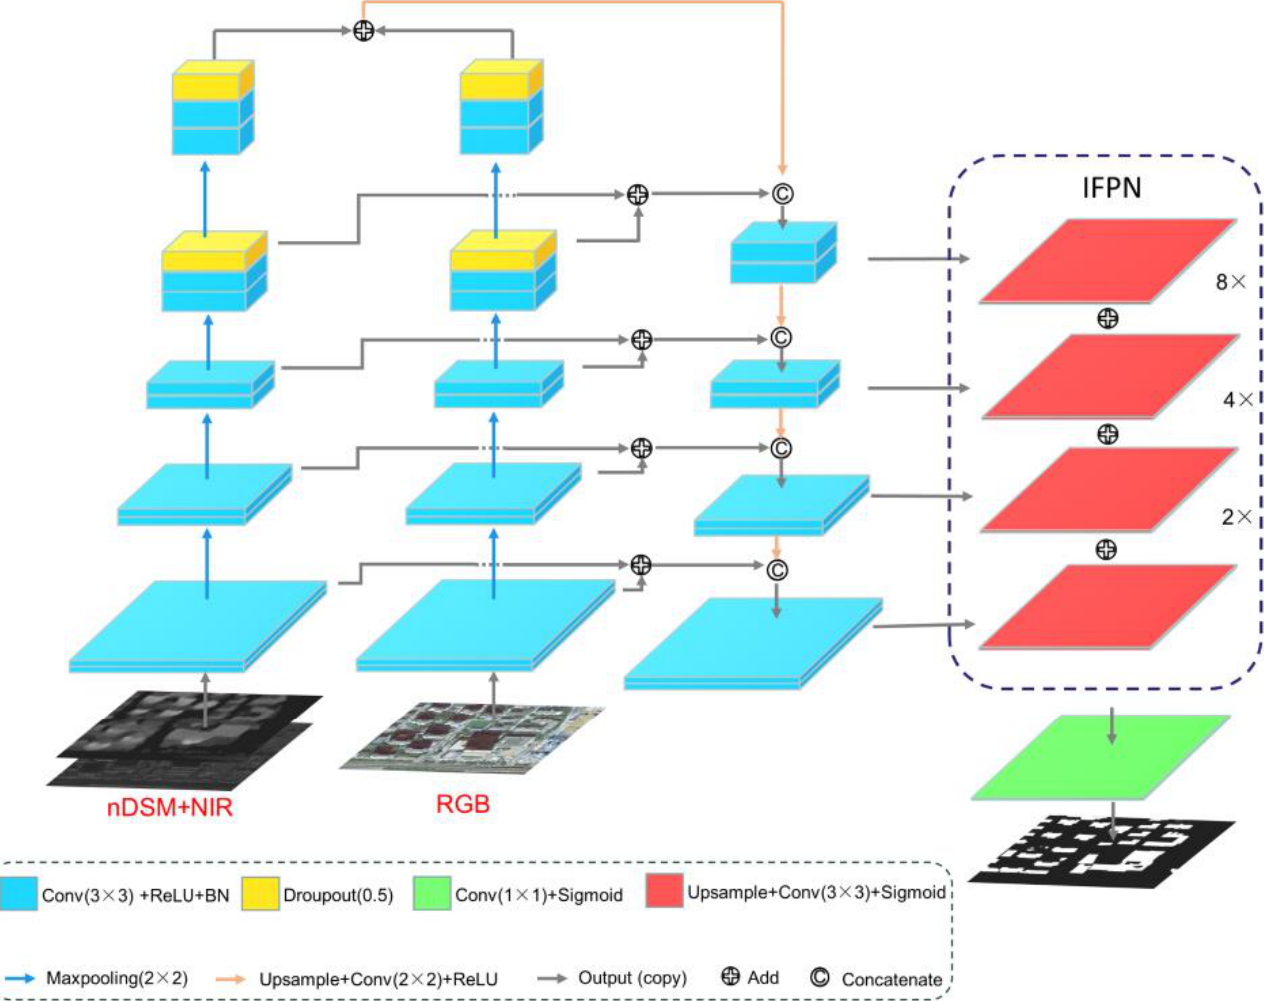
Figure 3. DMU-Net architecture.